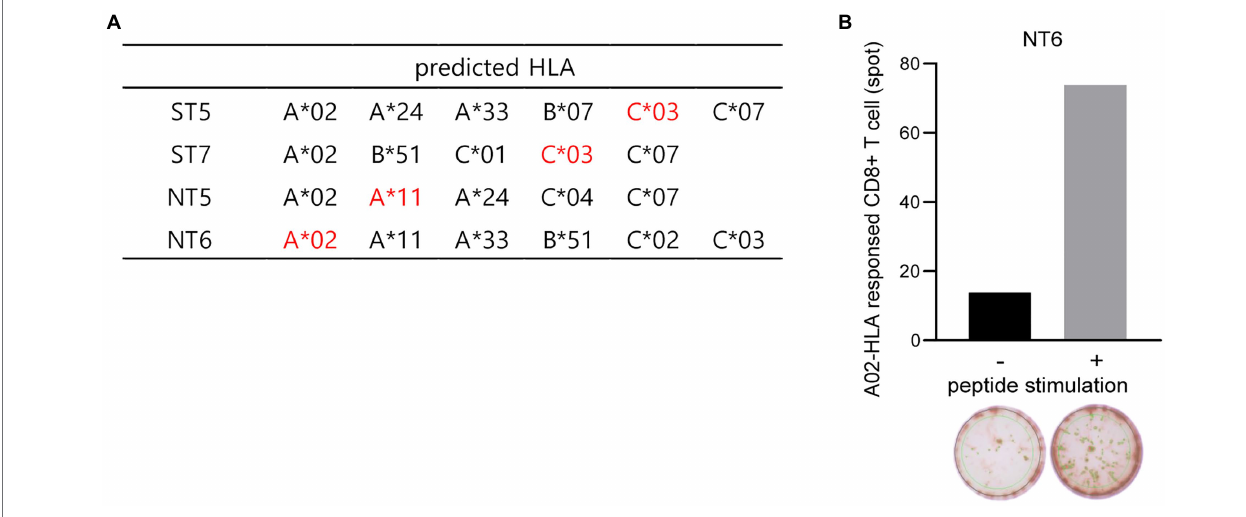
FIGURE 7 | Binding prediction of the SARS-CoV-2-derived peptides to human HLA and in vitro CTL response in human PBMCs. (A) Human HLA predicted to bind to the selected four peptides. Red indicates HLA predicted to bind mainly to each peptide. (B) Detection of the NT6 peptide-specific CTL in human HLA-A*02-type T cells via in vitro induction using a peptide-specific CTL